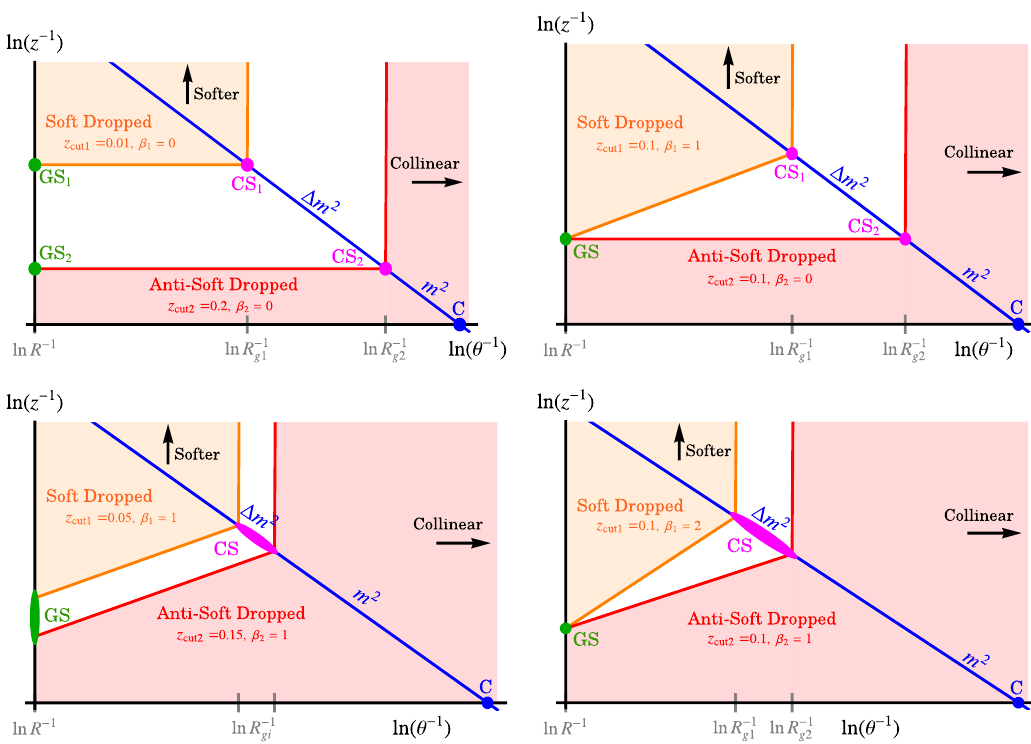
Figure 7 . Regions kept by Collinear Drop in the plane of energy fraction ( z ) and polar angle from the jet axis ( (cid:18) ). Results are shown for four di(cid:11)erent values of with the corresponding modes needed for the SCET calculation. In the top two panels we have two collinear-soft (CS) modes and two global soft (GS) modes, while in the lower panels one or both of these pairs are combined into a single